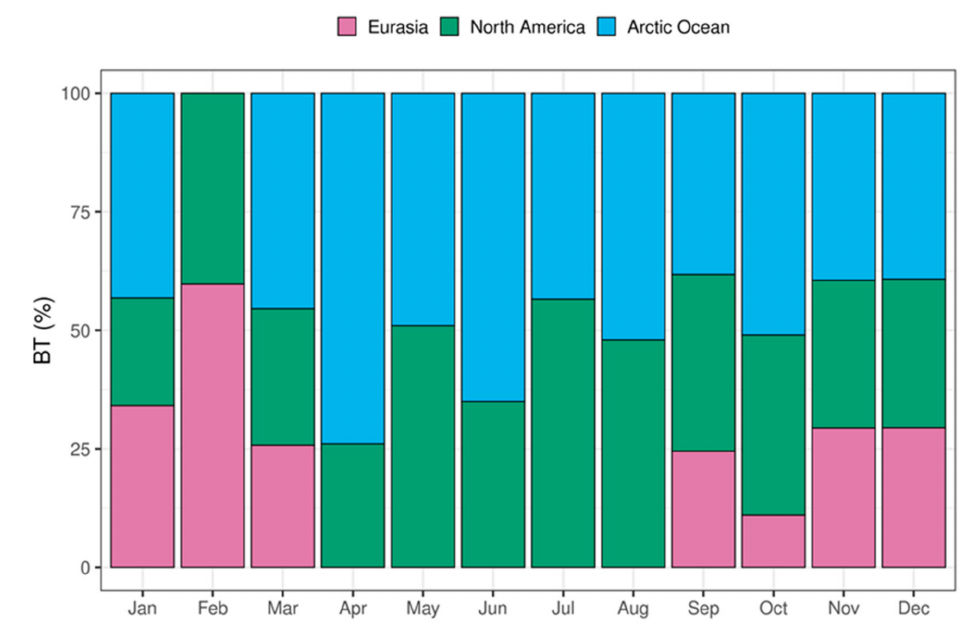
Figure 6. Median of the fraction of back-trajectories belonging to clusters associated to the macro- sectors Eurasia, North America, and Arctic Ocean (defined in the text) for the period